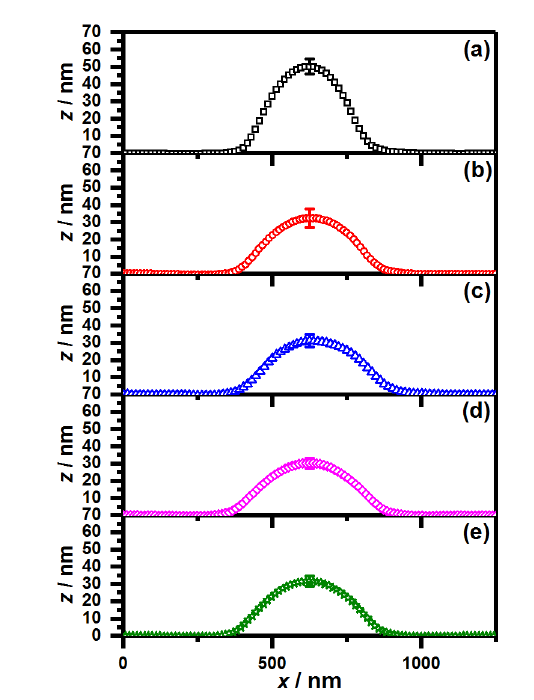
Figure 3. Averaged AFM height profiles of all core-shell microgels with a PNIPAM- co -AAc core and a shell composed of ( a ) PNN100/PMAM0; ( b ) PNN75/PMAM25; ( c ) PNN50/PMAM50; ( d ) PNN25/PMAM75 and ( e ) PNN0/PMAM100. The error bar was extracted from the standard deviation of all individual height profiles at the particle